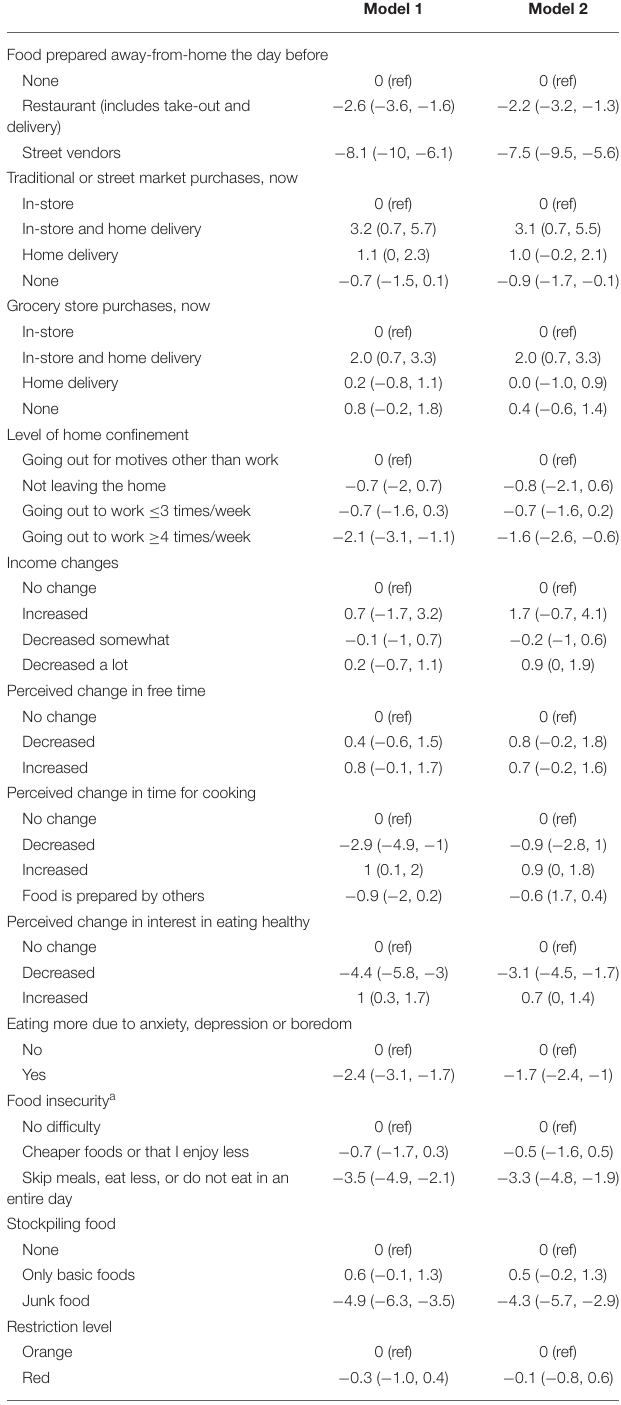
TABLE 2 | Association between pandemic related-factors and diet quality score during the 1st survey